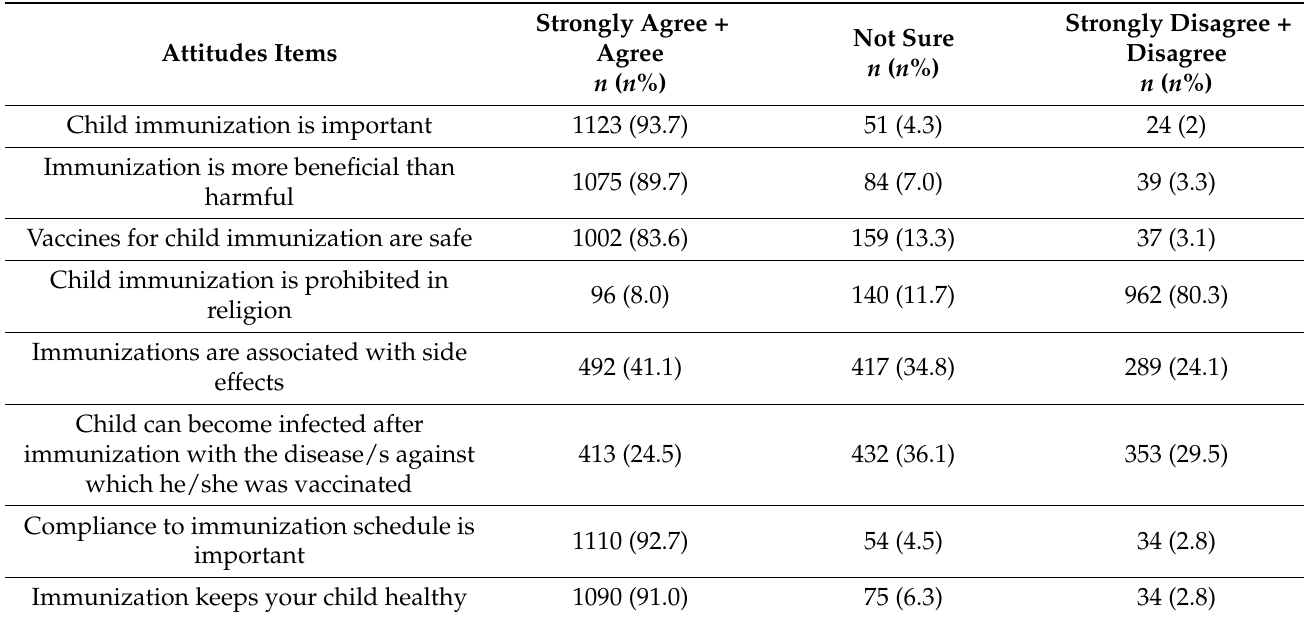
Table 3. Saudi parental attitudes on child immunization.